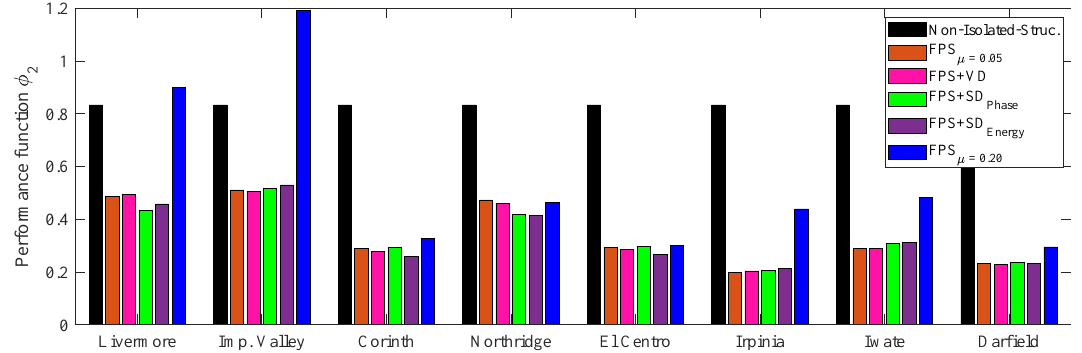
Figure 17. Performance function φ 2 of the configurations studied for the eight